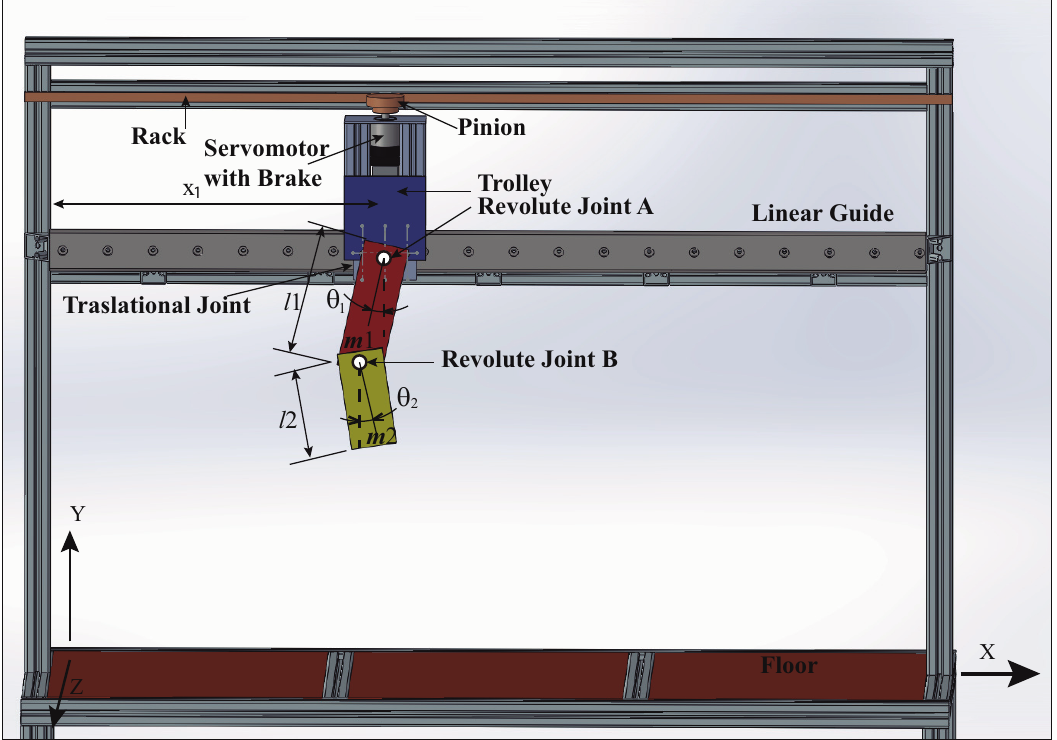
Figure 6. Sketch of the overhead crane Funtional Mock-Up Interface (FMI) with double pendulum multibody payload dynamics. Conditions: first link, length l 1 mass m 1 , plus moment of inertia about the mass center I G 1 zz ; second link, length l 2 mass m 2 , plus moment of inertia about the mass center I G 2 zz